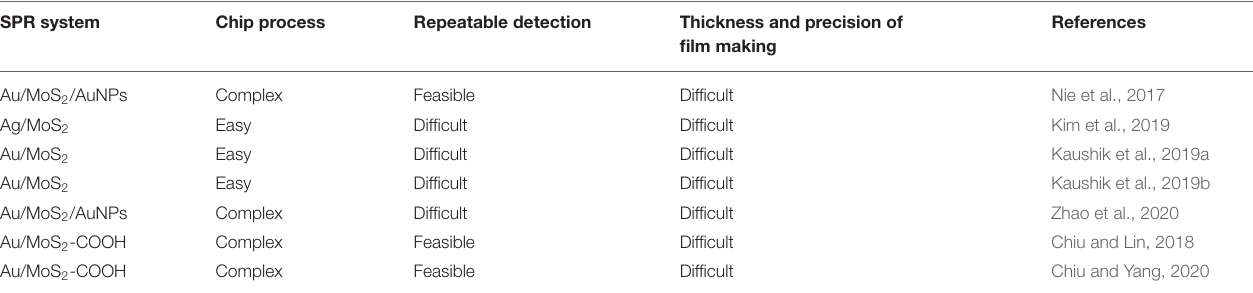
TABLE 4 | Molybdenum disulfide–based SPR chip, which has been successful in fabrication, advantages, and disadvantages. SPR